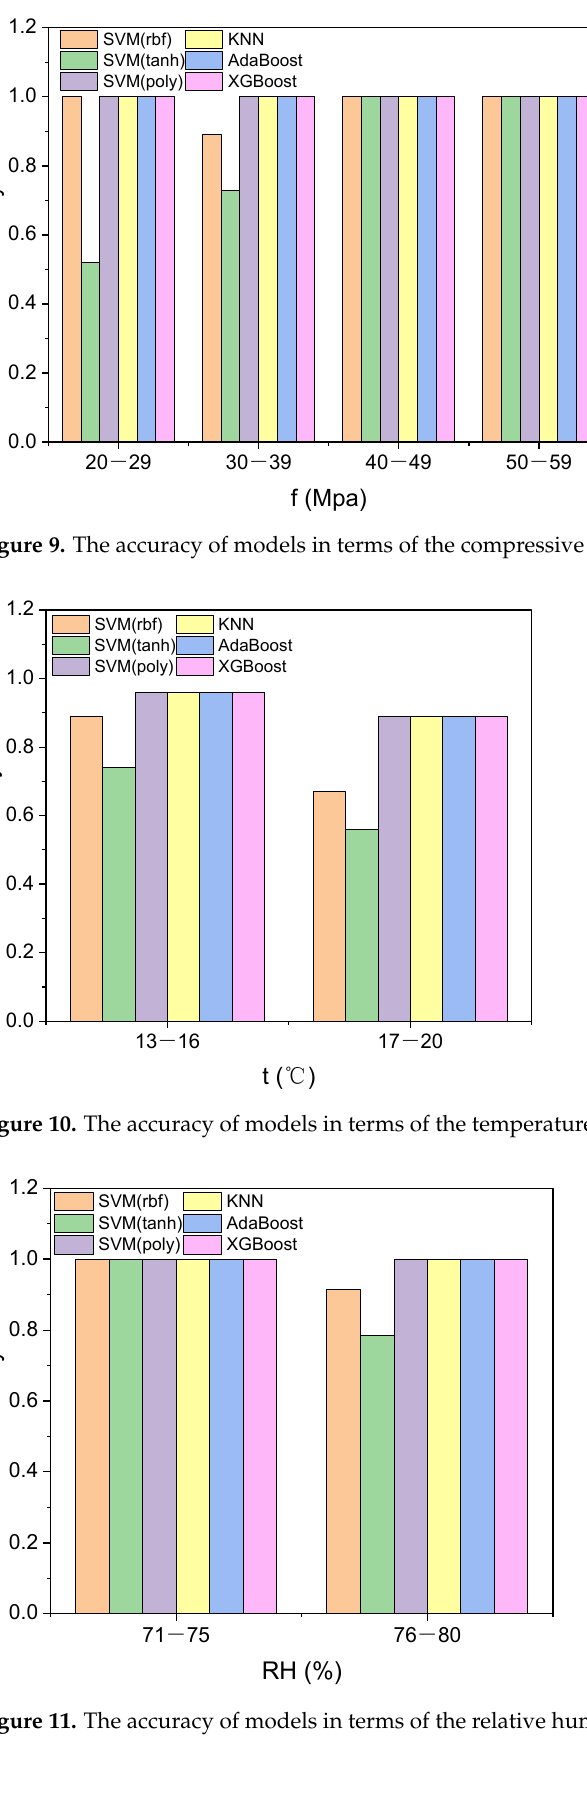
Figure 8. The accuracy of models in terms of the service time of concrete.